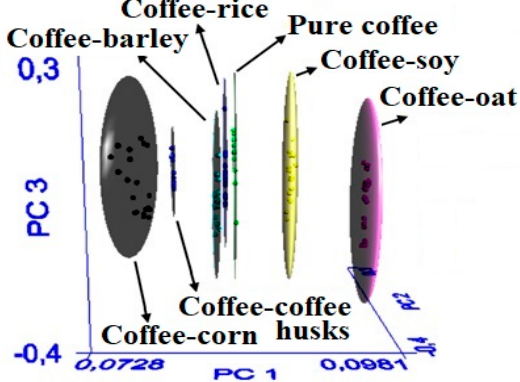
Figure 2. Spatial distribution of the classification SIMCA model.